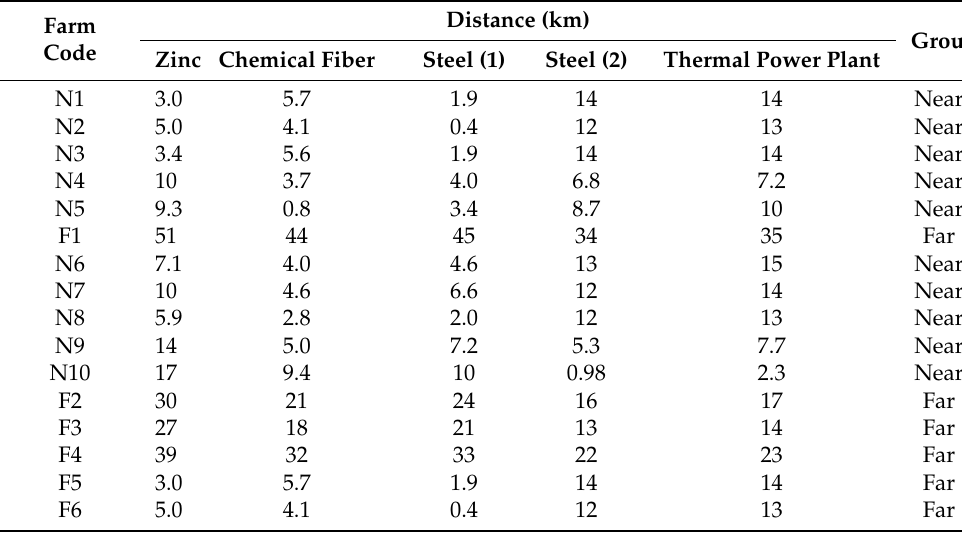
Table A1. Distance from farm to